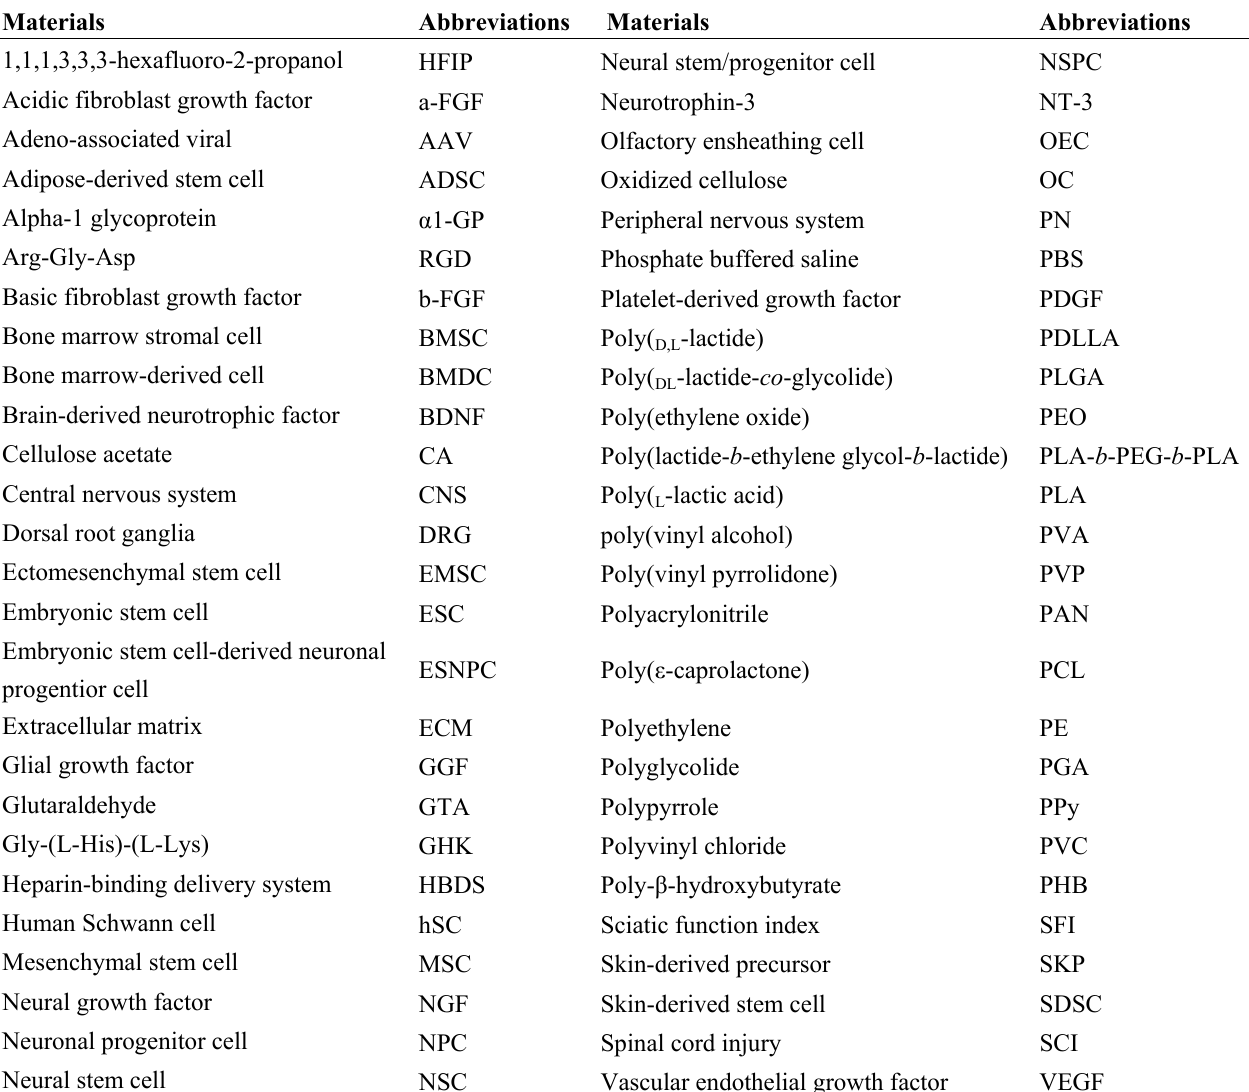
Table 1. Abbreviations of